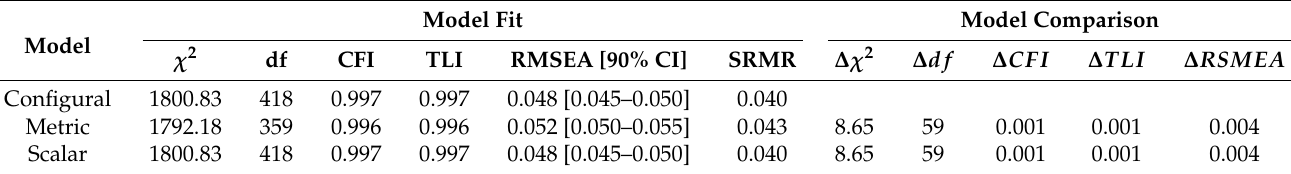
Table 4. Tests of invariance of the IGD-20